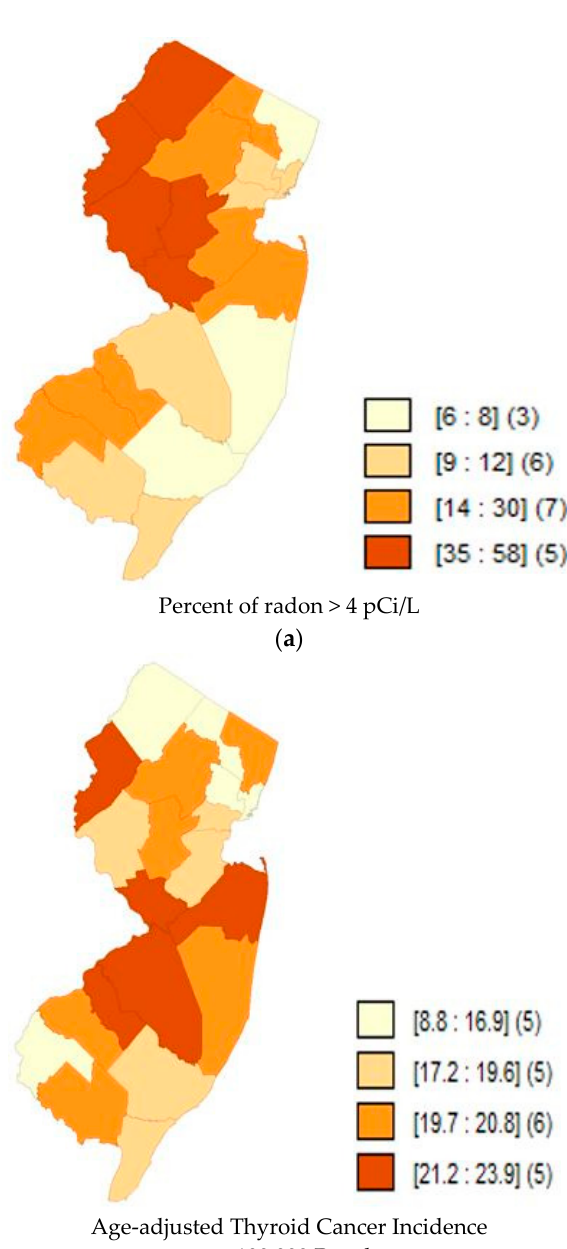
Figure 2. ( a ) Map of Quartiles of Radon Concentrations in New Jersey counties. Darker shades represent a higher percent of radon above 4 pCi/L. The numbers inside the brackets represent the range of percentages in that shade. The numbers inside the parentheses represent the number of counties in that quantile. Data accessed from AirChek, 2017. ( b ) Map of Quartiles of Age-adjusted Thyroid Cancer Incidence (1990–2013) in New Jersey counties. Darker shades of orange represent higher rates of thyroid cancer incidence. The numbers inside the brackets represent the range of incidence rates per 100,000 in that shade. The numbers inside the parentheses represent the number of counties in that quantile.